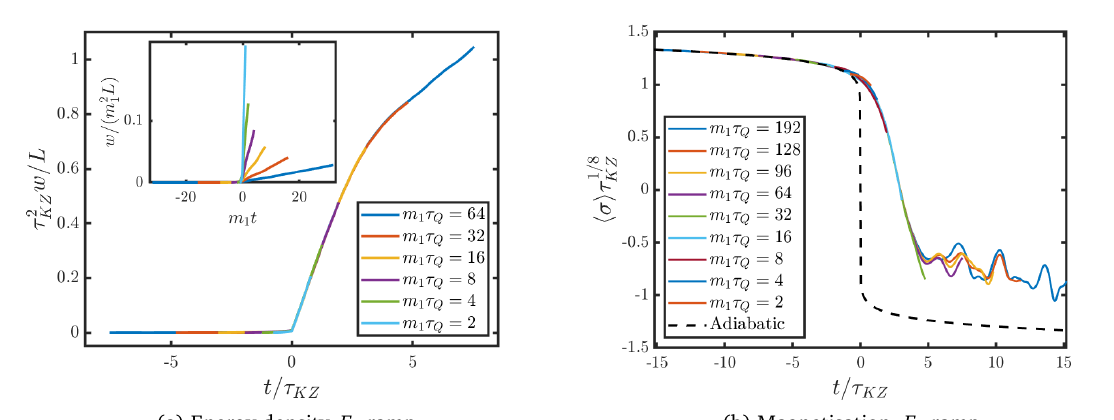
Figure 4.2: Dynamical scaling of the (a) energy density and (b) magnetisation in fi- nite ramps across the critical point along the E axis. The TCSA results obtained 8 L = 50 are extrapolated in the energy cutoff. The Kibble–Zurek scaling for m 1 ∼ τ 8 / 23 is present with τ . In panel (a) the inset shows the ‘raw’ curves with- KZ Q out rescaling. In (b) the dashed black line shows the exact adiabatic value [ 102 ] : 〈 σ 〉 = ( − 1.277578... ) · sgn ( h ) | h | 1 / 15 ad